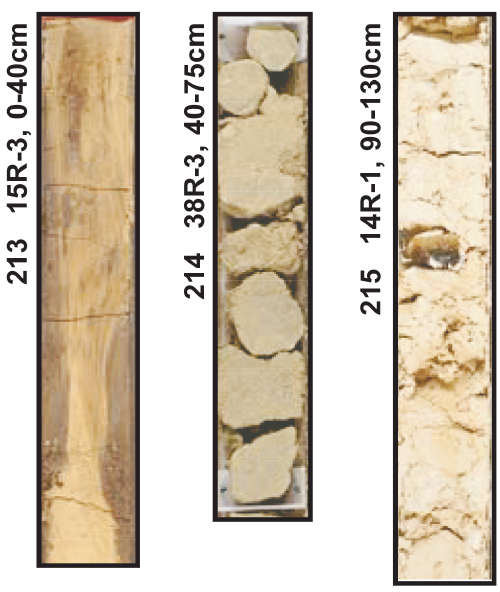
Figure 6. Core photos of disturbed sediment intervals recovered at each of the sites examined. When drilled in 1972, the sites were cored using rotary methods. As a result, there is considerable drilling disturbance over certain